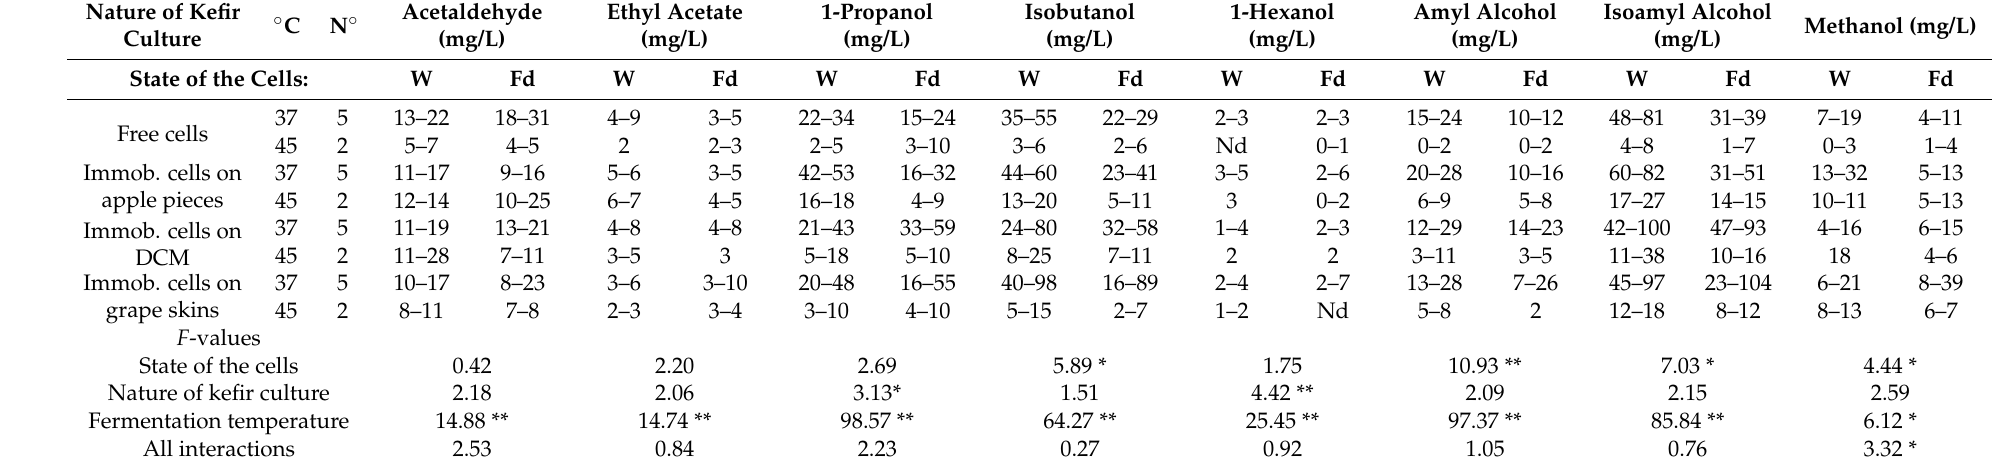
Table 3. Effect of cell immobilization, freeze-drying, and high temperature on major volatiles in semi-dry and sweet low alcohol wines produced by repeated batch fermentations using kefir